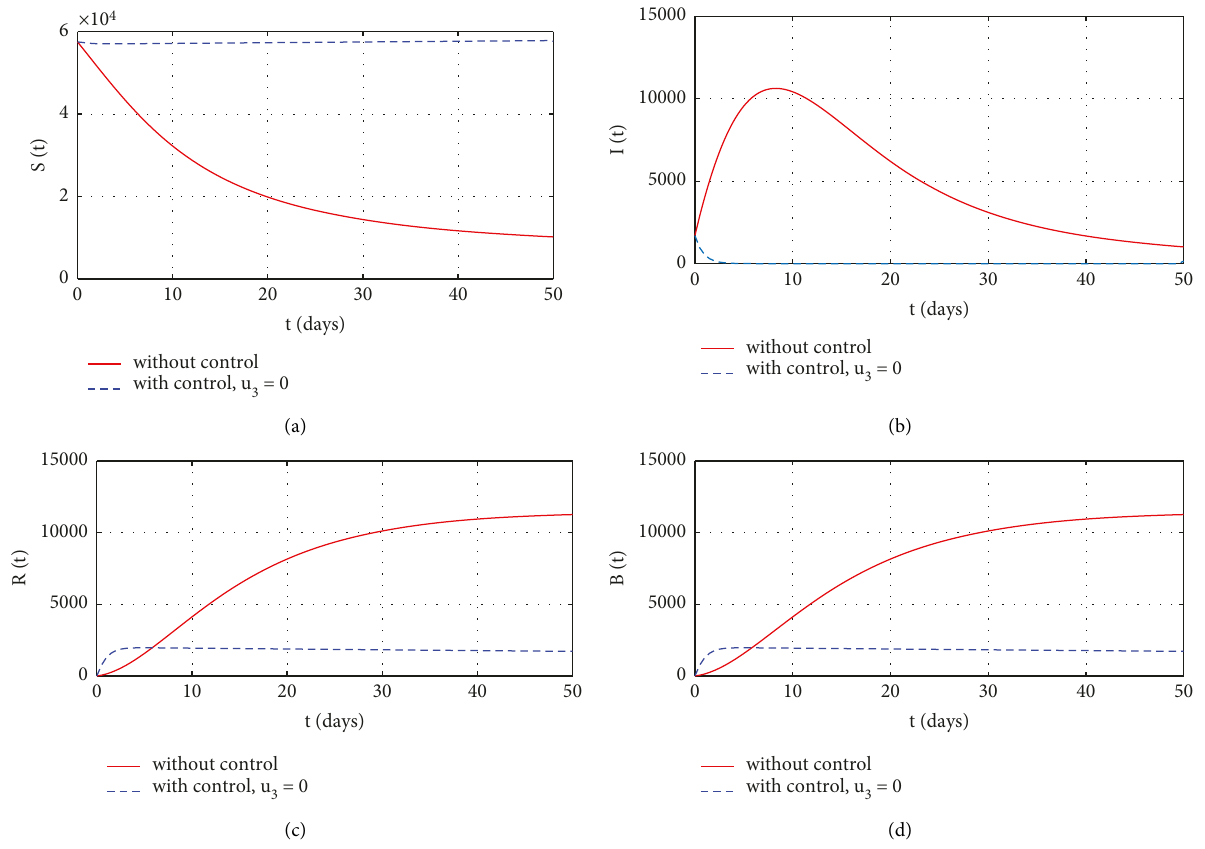
Figure 8: Numerical simulations of combination of vaccination, treatment of infective individuals, and hygiene.